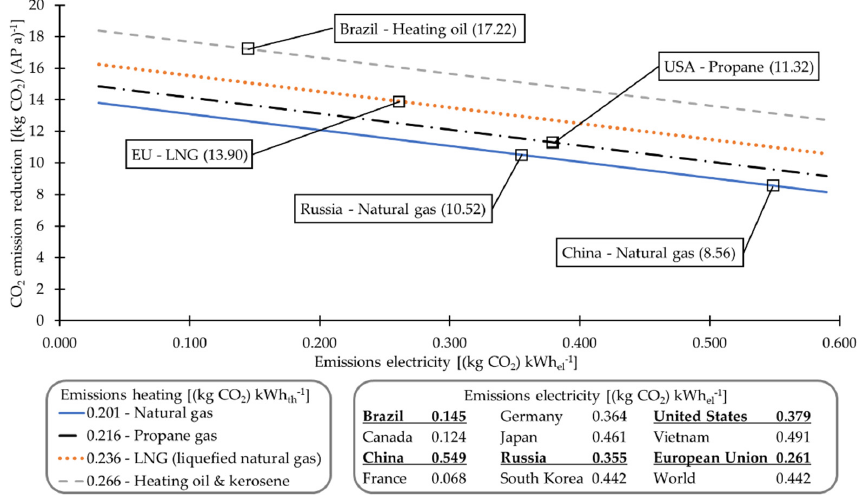
Figure 10. Annual CO 2 emission reduction [(kg CO 2 ) (AP a) − 1 ] for various scenarios concerning emission factors for electricity and heat input [(kg CO 2 ) kWh el,th − 1 ]. The annual reduction quantities consider the 4140 animal places (AP) for piglet rearing in the barn. The calculations are based on the electrical energy consumption for the heat recovery Q HR,el (41,888 kWh el ) and heat recovered Q HR,th (290,414 kWh th ) of trial year 1 (17 December 2019–15 December 2020). Emission factors for fossil fuels are given by [27,61] and for the countries’ or regions’ electricity production, respectively, for the year 2021 by [17] (the factor for Germany differs compared with the other calculations in this article due to various literature values and reference years). EU = European Union.